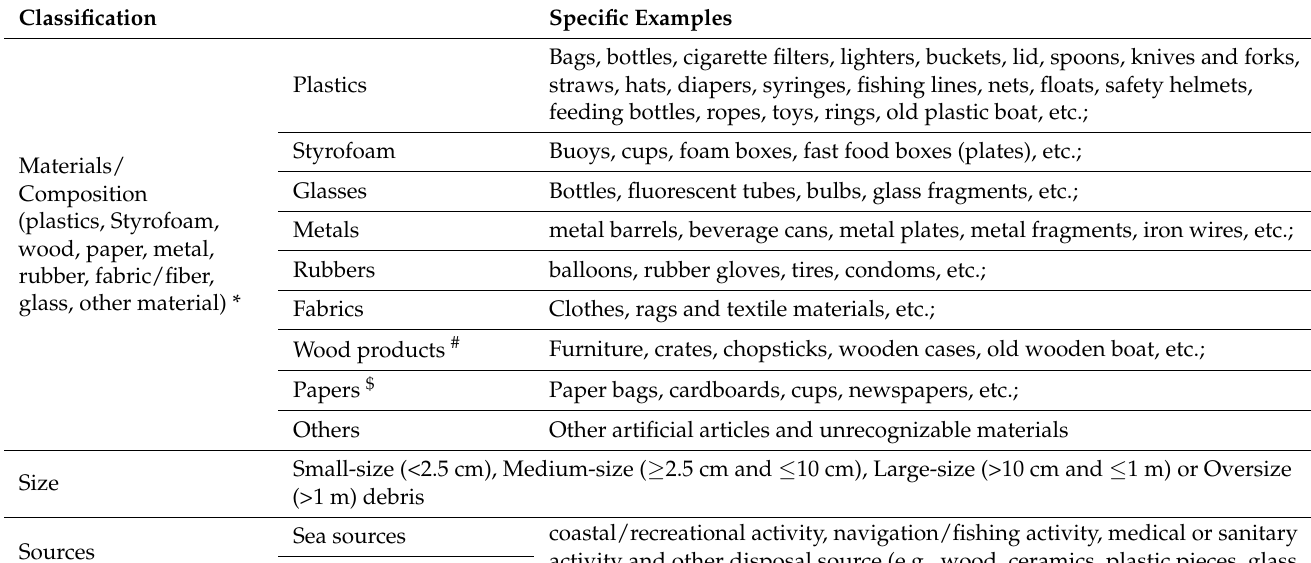
Table 1. List and classification of the debris based on the size, materials and